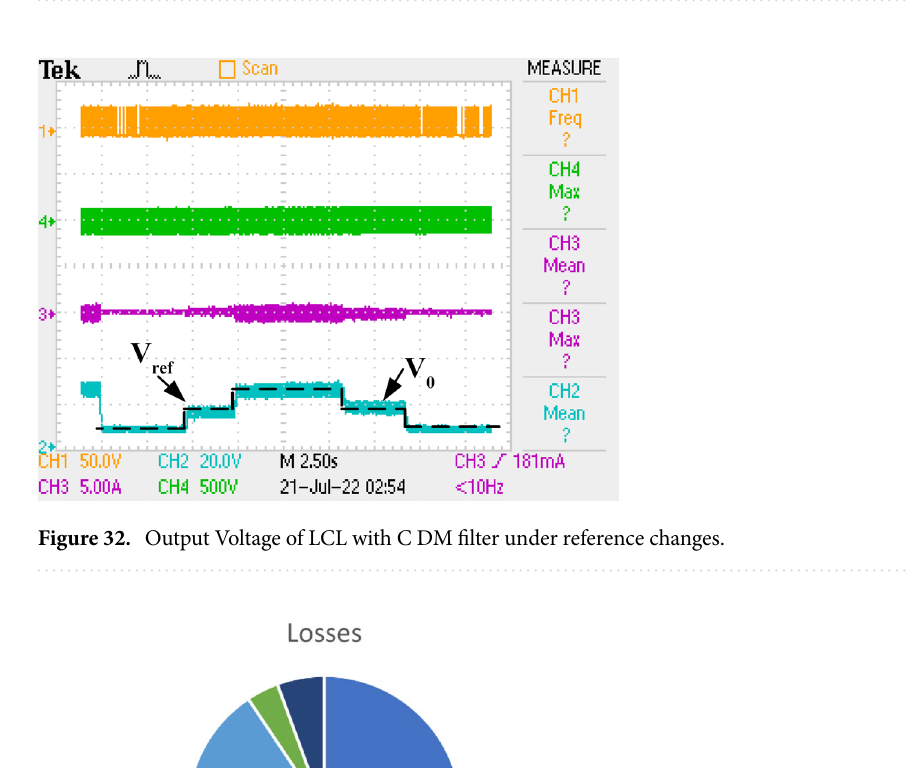
Figure 31. By LCL with C DM filter, THD of grid current, for Si Mosfet.